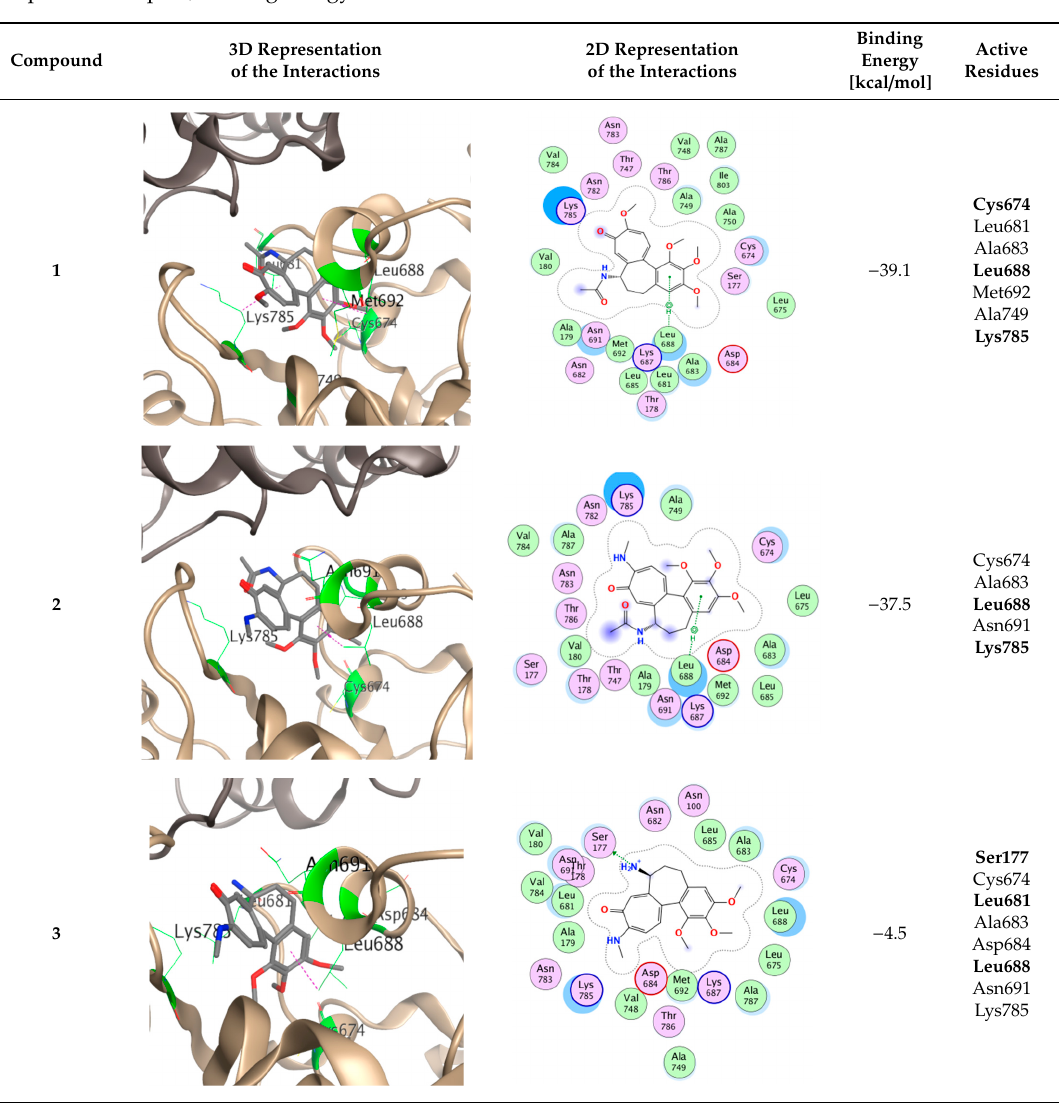
Table 2. Computational predictions of interactions between starting compounds 1 – 3 , most cytotoxic 14 and homology modeled tubulin β I. 3D representation and 2D layout of colchicine derivatives–tubulin protein complex, binding energy and active residues are tabulated.